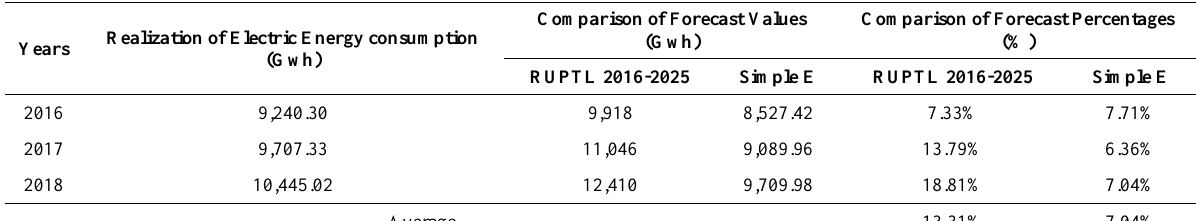
Table 9. Comparison of forecast results